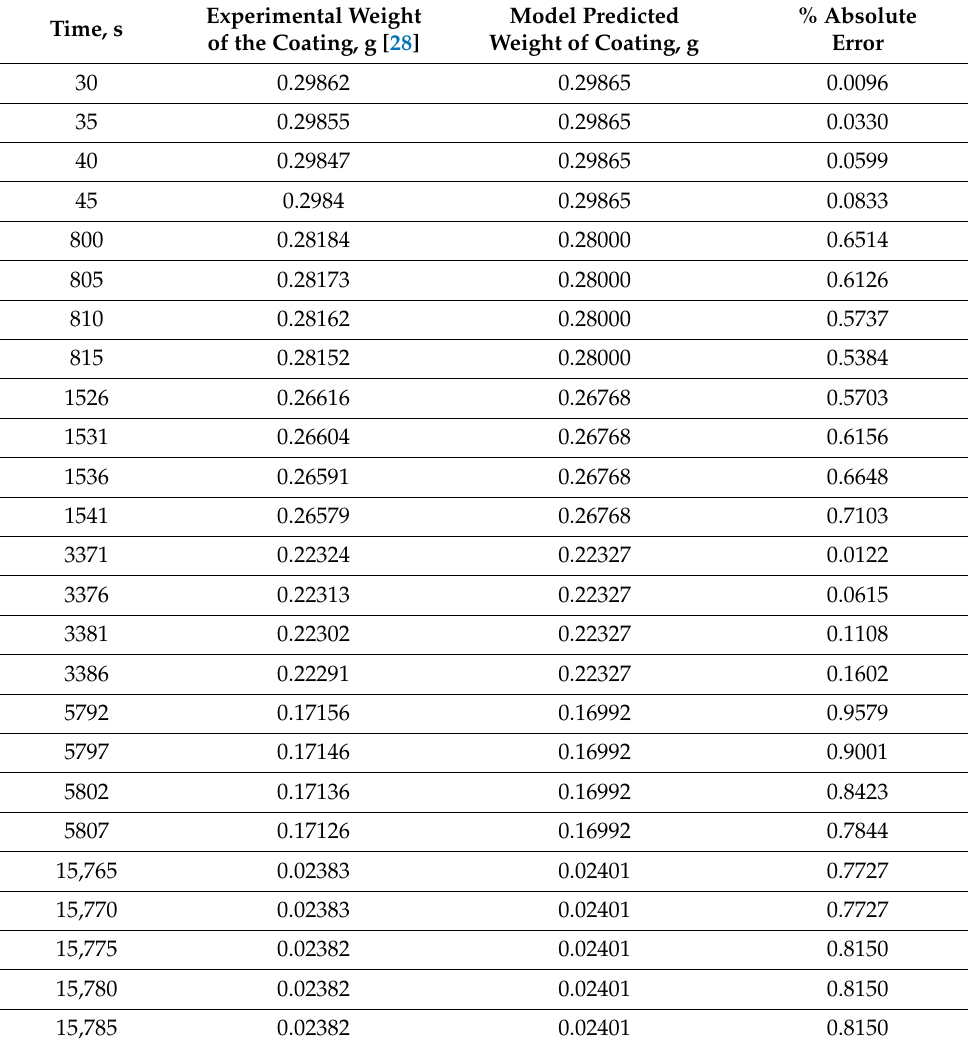
Table 2. Sample error between predicted and experimental values for 2011 µ m initial coating thickness with poly(styrene), p -xylene, and TPP contents of 5.02%, 94.46%, and 0.52%,